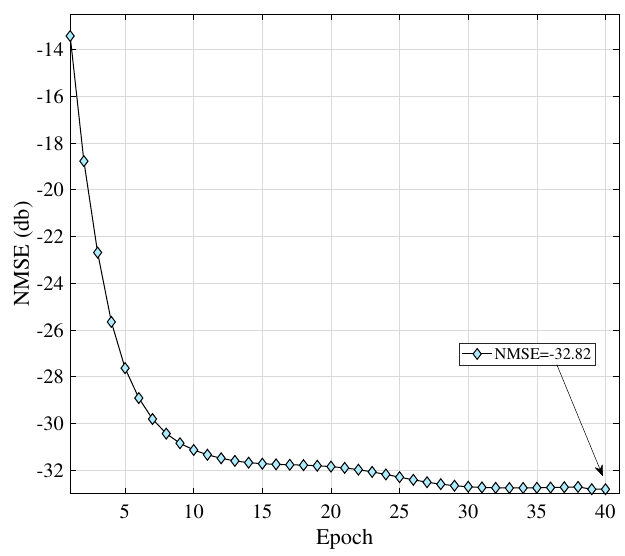
Figure 16. NMSE evolution by means of EKF training.